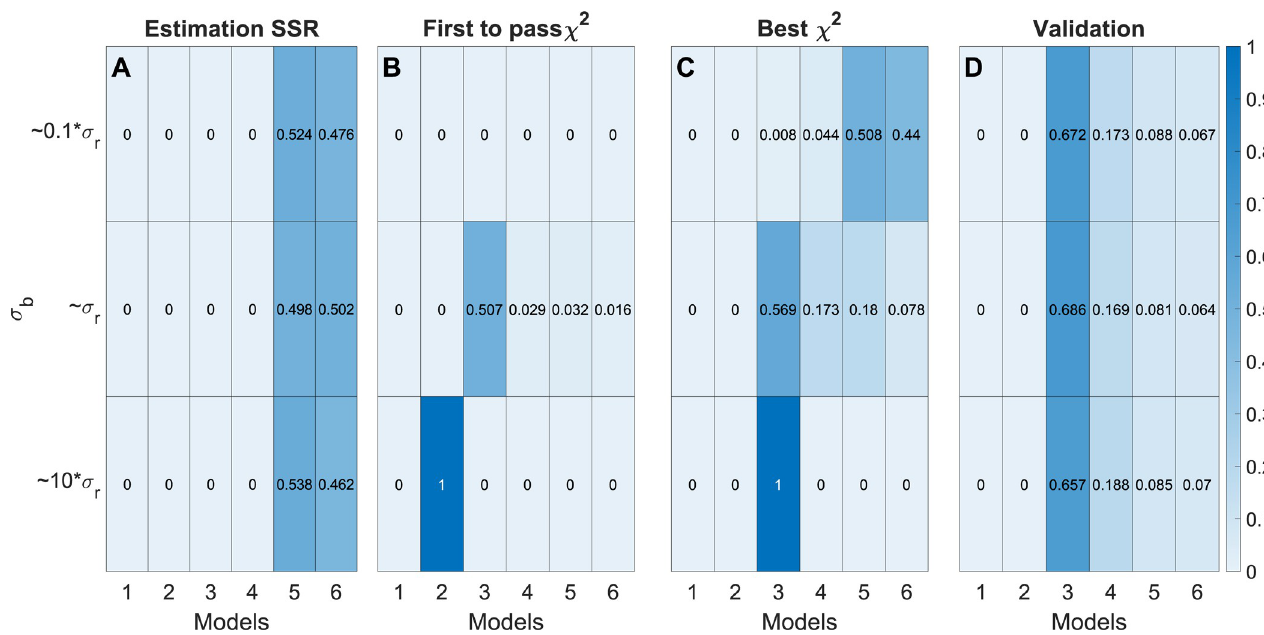
Fig 6. Model selection results for the linear model example. (A–D) Heatmaps represent results from the indicated selection methods, where rows represent different values of σ b and columns represent the linear models A 1 , ... ,A 6 . For each row, color indicates the fraction of times a model is selected for the given σ b , out of 1000 samples, as indicated by the color scale (right).